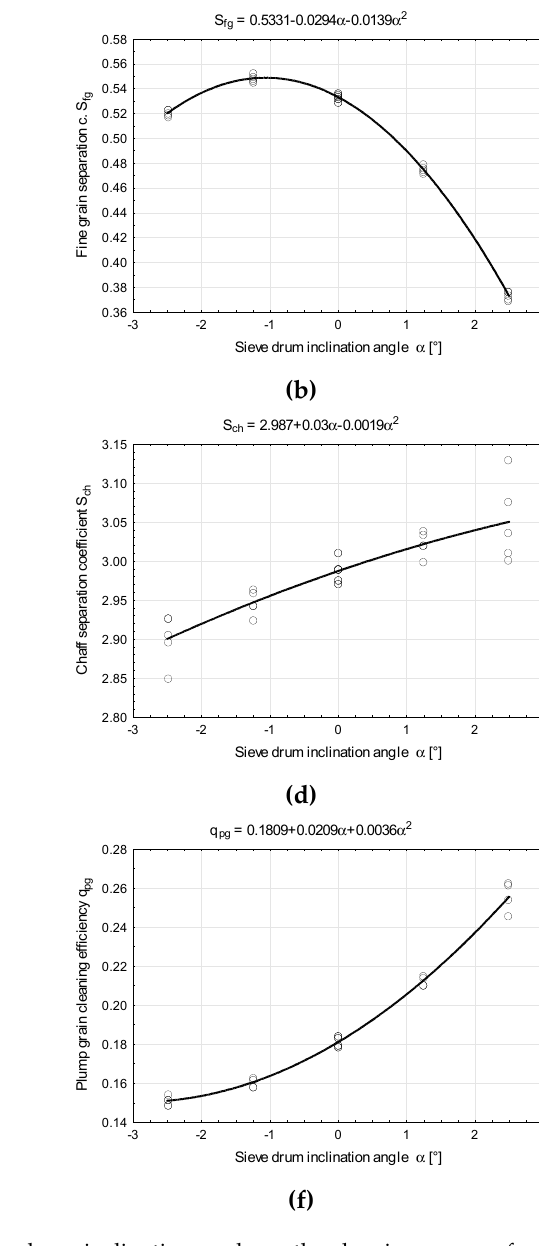
Figure 4. Analysis of the influence of the sieve drum inclination angle on the cleaning process for ν d = 75 rpm: (a) plump grain separation coefficient S pg , (b) fine grain separation coefficient S fg , (c) fine impurities separation coefficient S fi , (d) chaff separation coefficient S ch , (e) total coefficient of cleaning effectiveness E , (f) plump grain cleaning efficiency q pg .